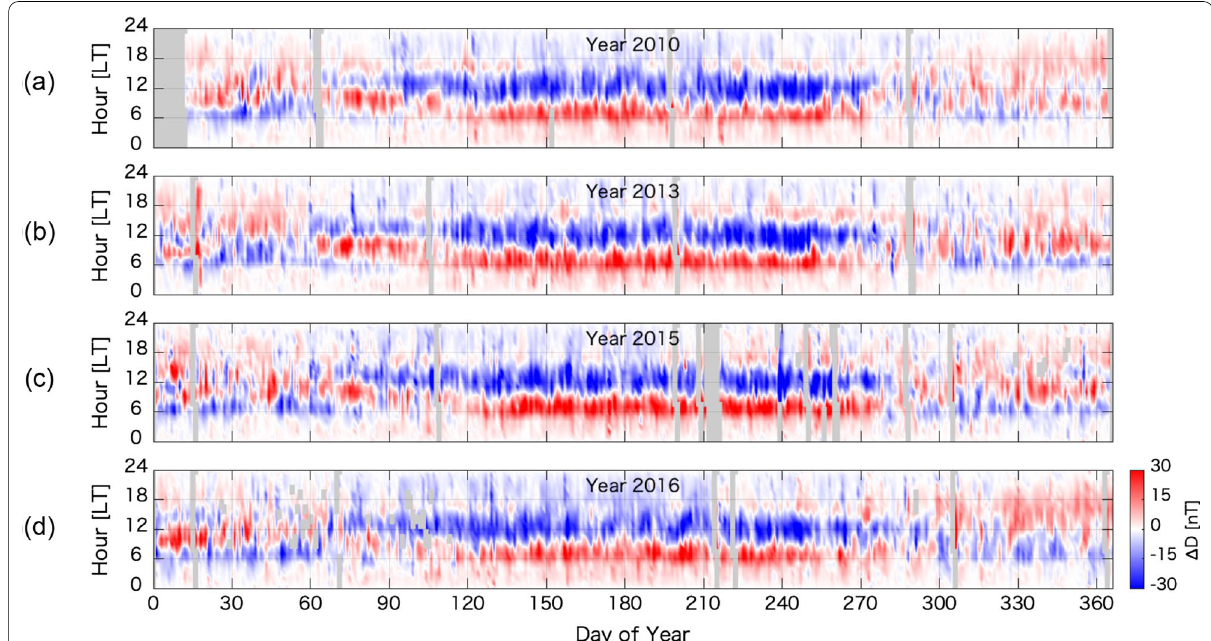
Fig. 1 Daily ∆ D variations at Davao as a function of local time and day of year. a 2010, b 2013, c 2015, d 2016. The color bar shows the intensity of ∆ D . The red ( eastward ∆ D ) and blue ( westward ∆ D ) colors correspond to the southward IHFACs and the northward IHFACs, = =